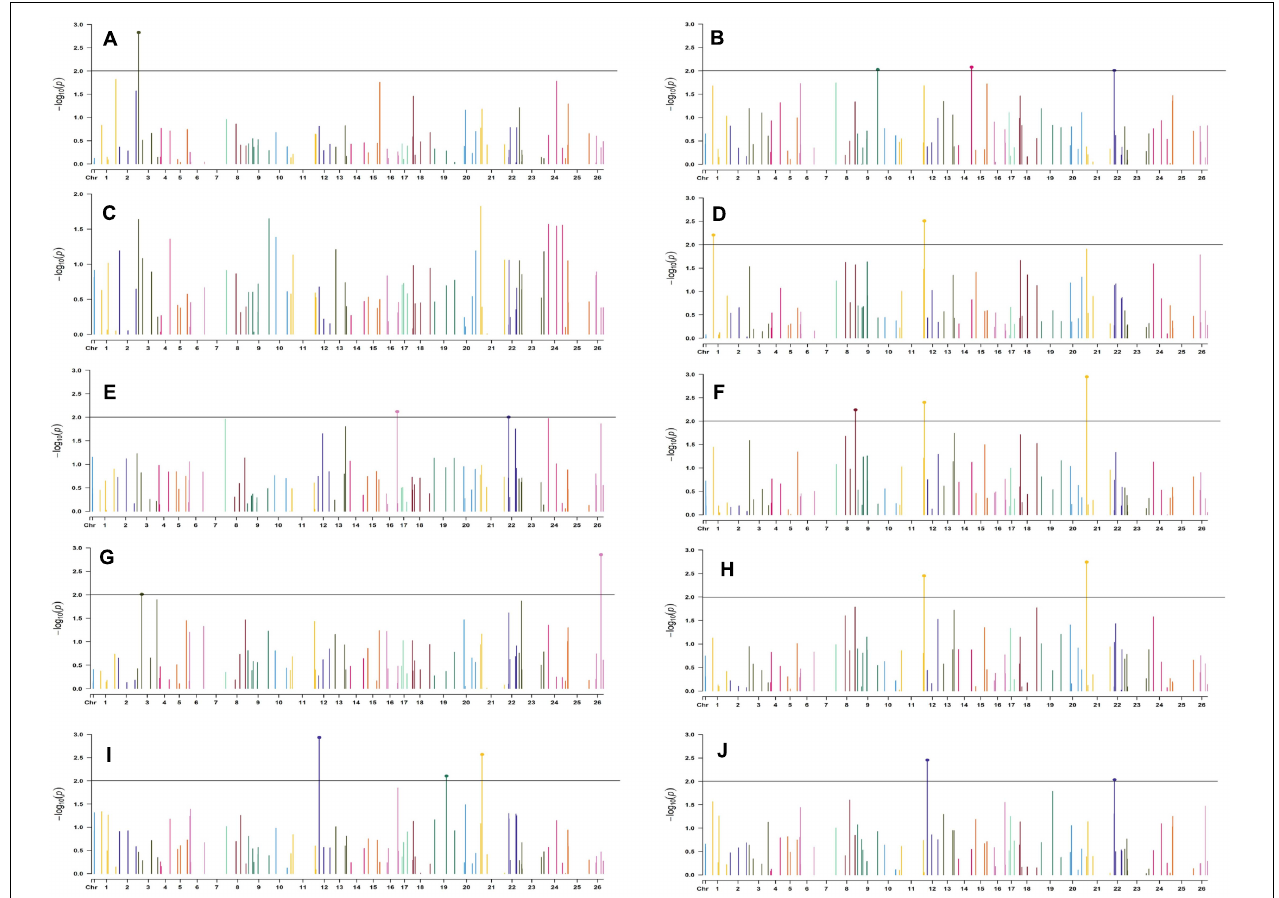
FIGURE 9 | Manhattan plots for the late sown environment of 2018 for various traits under study by the MLMM model. Significant marker above threshold {at –log10 ( p ) > 2} is highlighted with bold dot head on the marker’s line. (A) Days to first flower, (B) plant height, (C) number of monopods, (D) number of bolls per plant, (E) boll weight, (F) seed cotton yield per plant, (G) ginning out turn, (H) lint yield, (I) seed index, and (J) lint